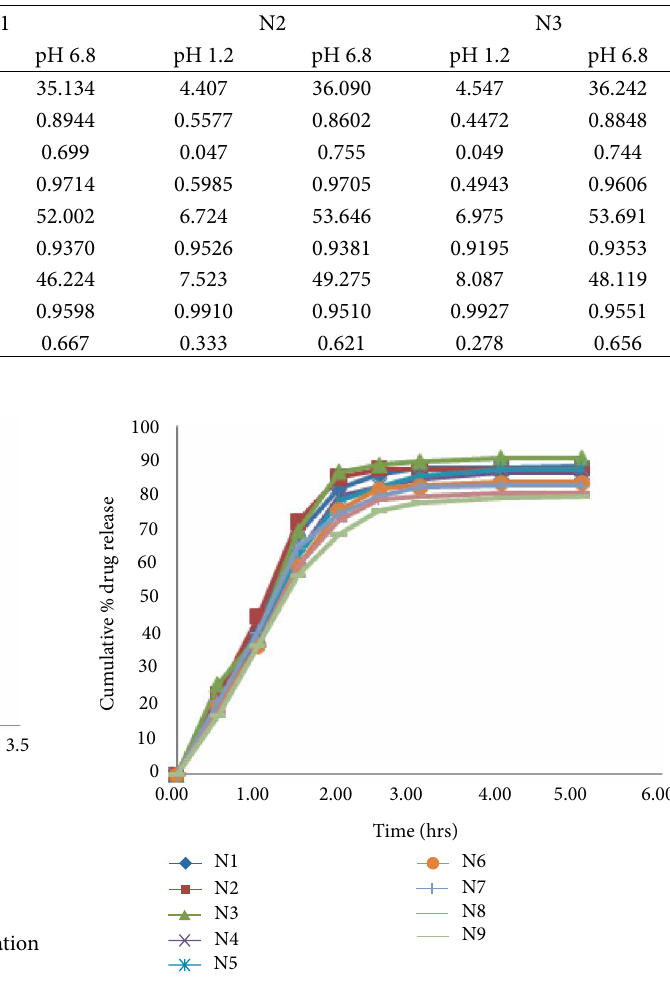
Figure 9: Cumulative percentage drug release from formulation (N1–N9) at pH